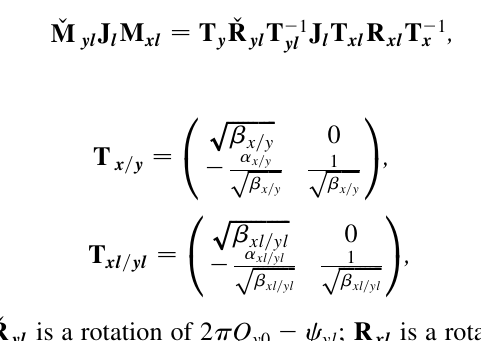
p ffiffiffiffiffiffiffiffiffiffiffiffi (cid:3) xl=yl p 1 ffiffiffiffiffiffiffiffiffi (cid:2) (cid:6) xl=yl ffiffiffiffiffiffiffiffiffi (cid:3) xl=yl